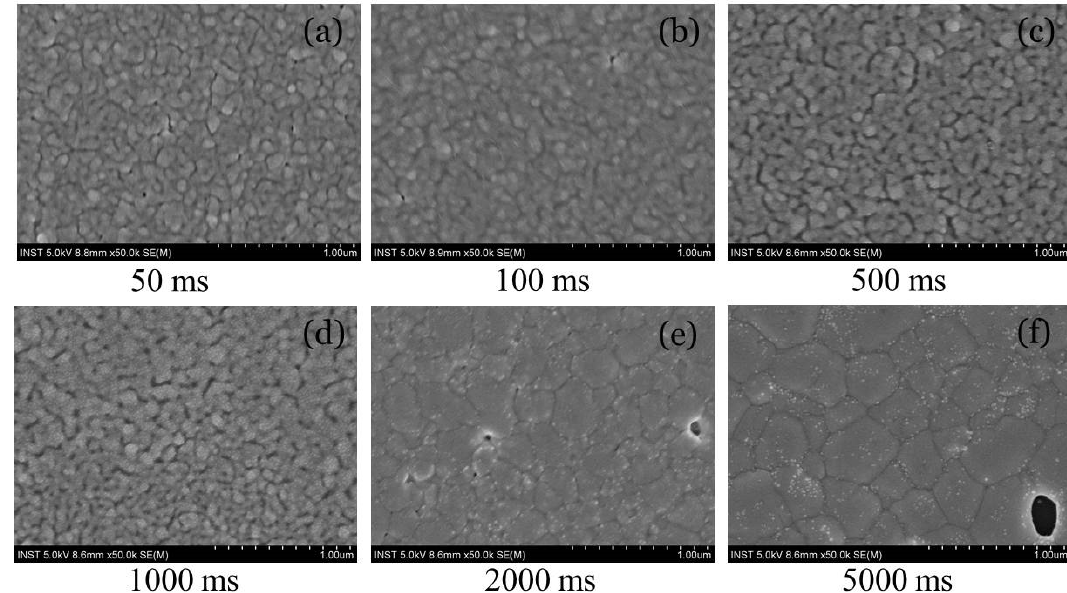
Figure 6. FE-SEM images of inkjet-printed silver nanoparticles sintered at a final-step current of 0.4 A at time durations of